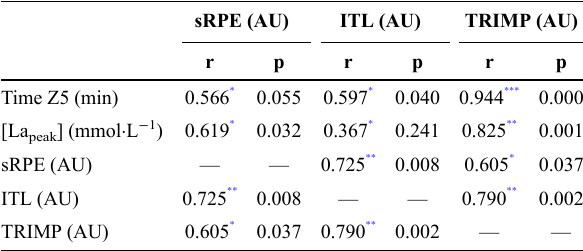
Table 2 - Correlations between training load monitoring methods based on the HR and RPE with the analyzed variables in the FT SESSION